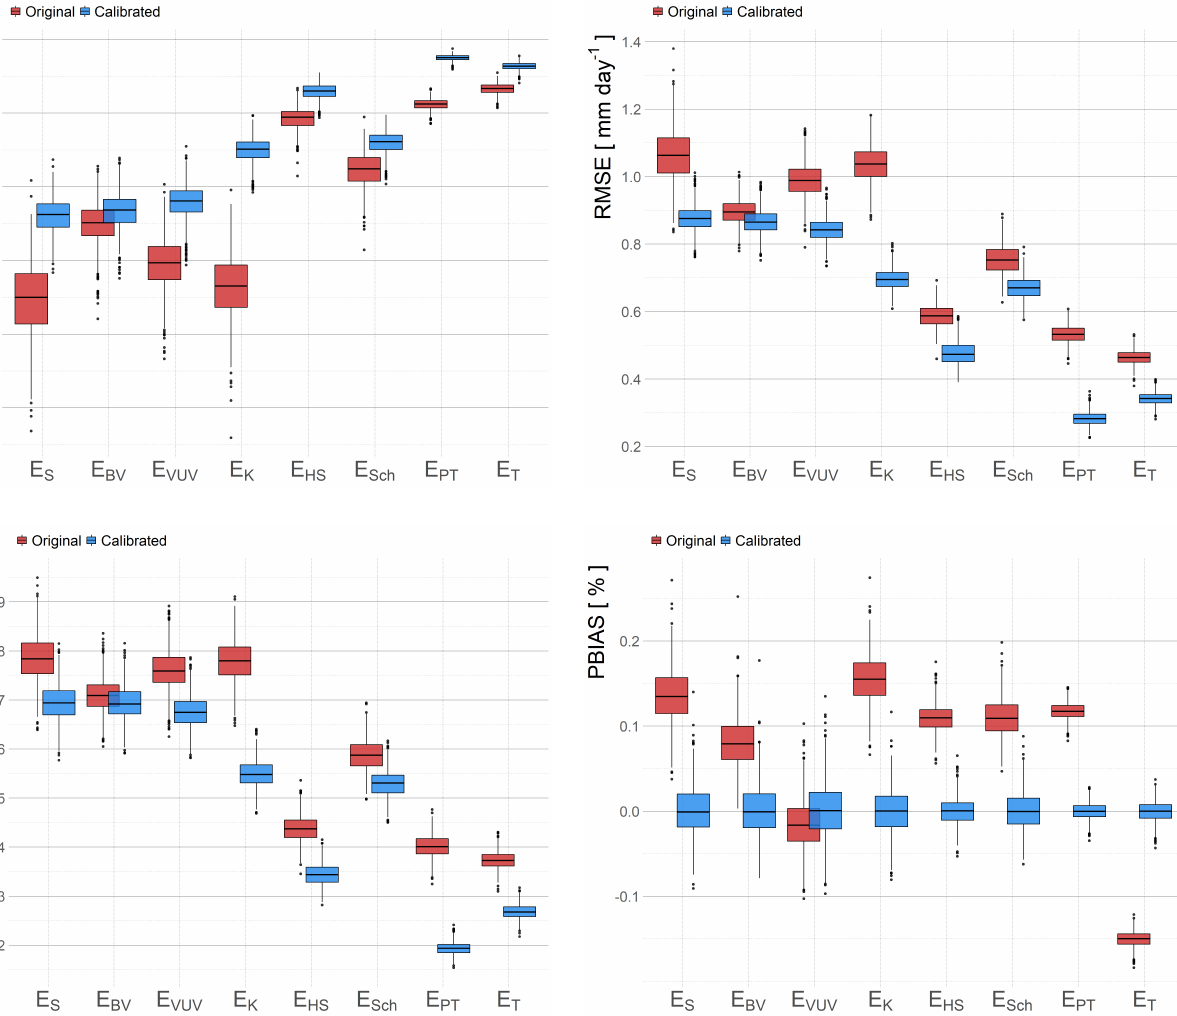
Figure 4. The comparison of the statistical measure of the original model and the calibrated model on the validation part of the data. From these results, the optimal calibrated model is the one that corresponds to the mean value of the calibrated statistical